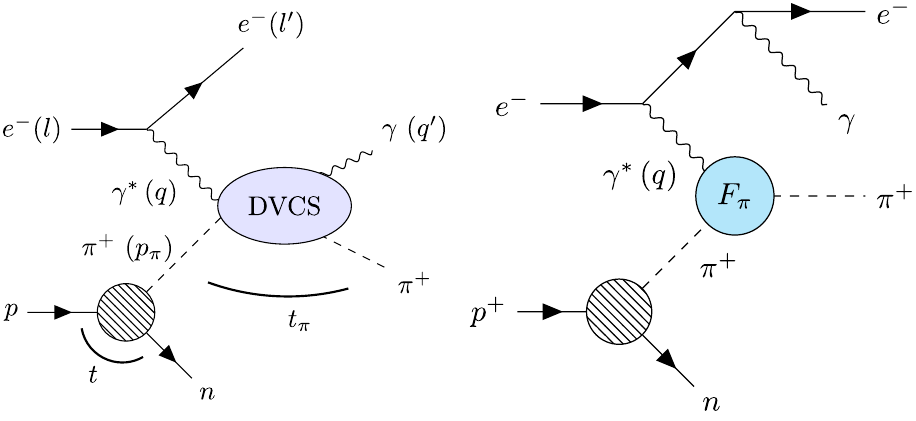
en γπ + . At small t , one expects the pion pole contribution to be Figure 12. Left : Sullivan DVCS ep → the leading one in such a process. Right : Sullivan Bethe–Heitler, interfering with the DVCS. The differential cross section of the complete process d σ Sul depends on